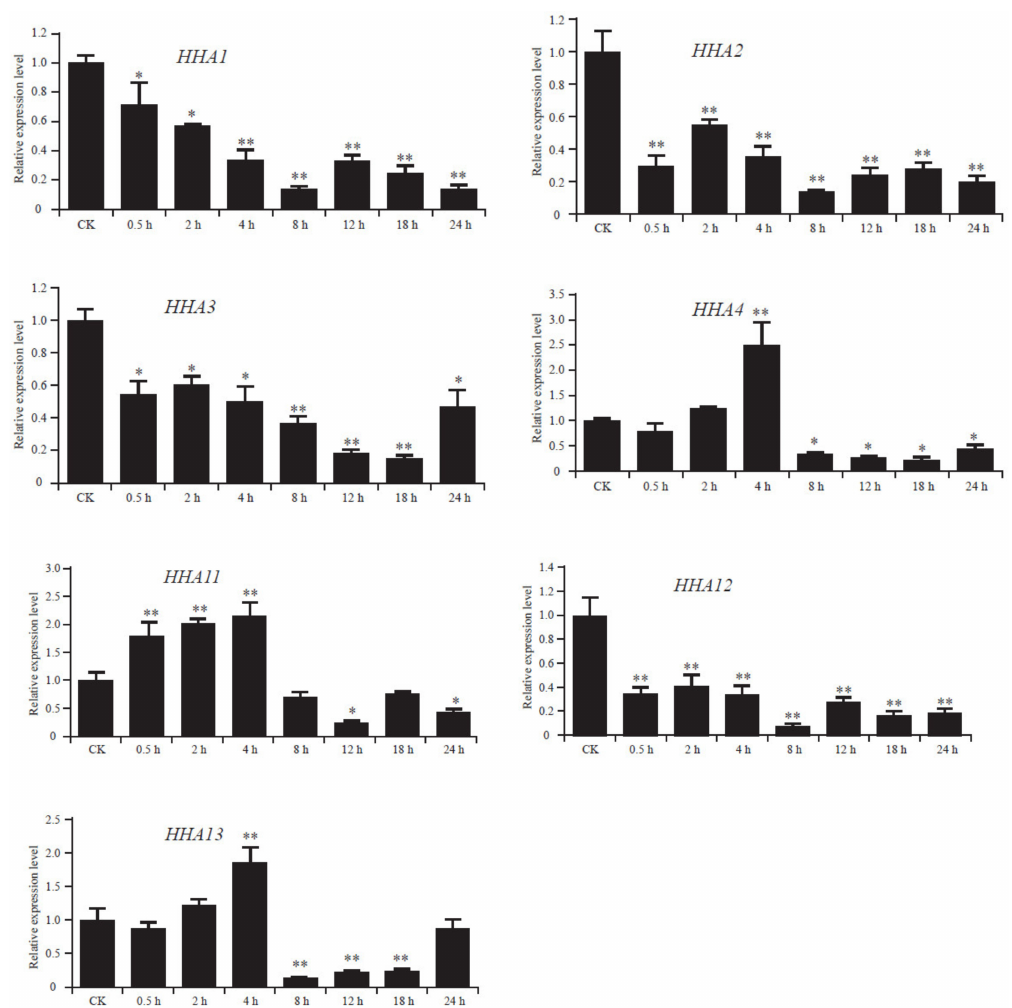
Figure 6. The relative expression levels of HHA genes under 150 mM NaCl stress. X -axis represents sampling time. CK is the plant that was not watered with NaCl solution. The error bar represents the standard deviation (SD) based on three biological replicates. The statistical significance was determined by the ANOVA method using SPSS software (* p < 0.05, ** p <